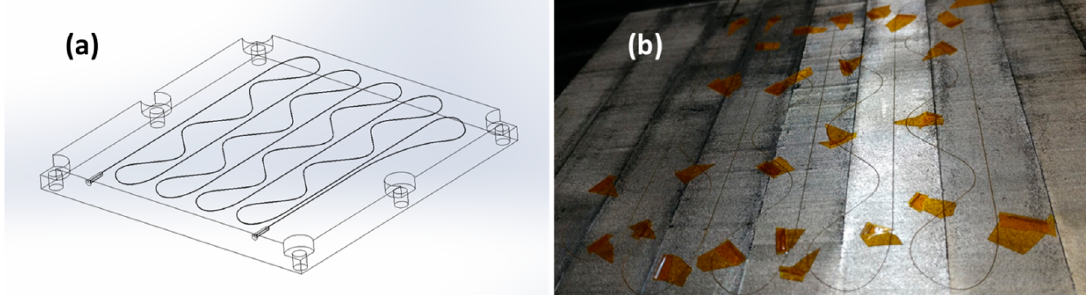
Figure 3. Fiber routing design of smart build-plate: ( a ) design showing internal fiber path; ( b ) fiber placement by inserting fiber into cut slot and using Kapton tape for temporary constraint during placement. Kapton tape is removed prior to consolidating. The internal fiber route used a strain Rosette pattern to measure three 2D strain states across the surface. Fiber was embedded close to the surface of printing to enhance sensitivity to surface strain events, i.e., delamination or cracking of the L-PBF samples.